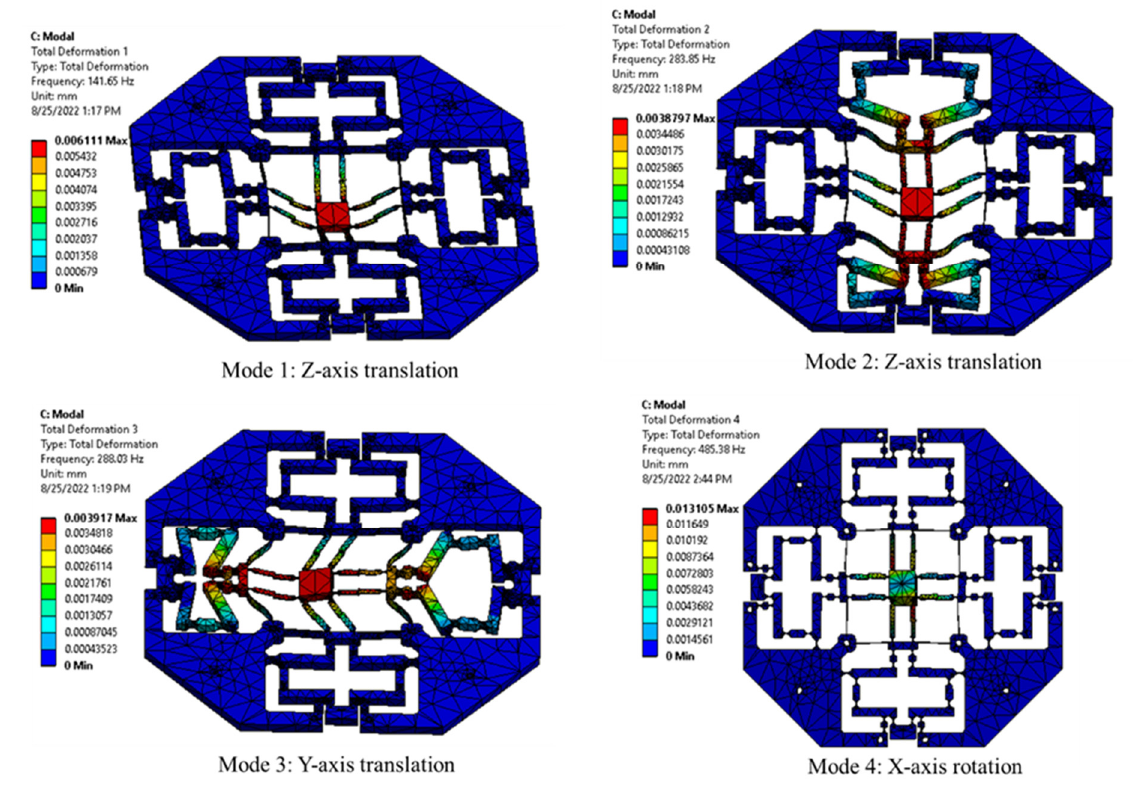
Figure 10. Dynamic performance of XYZ micropositioner with four of the first mode shapes.